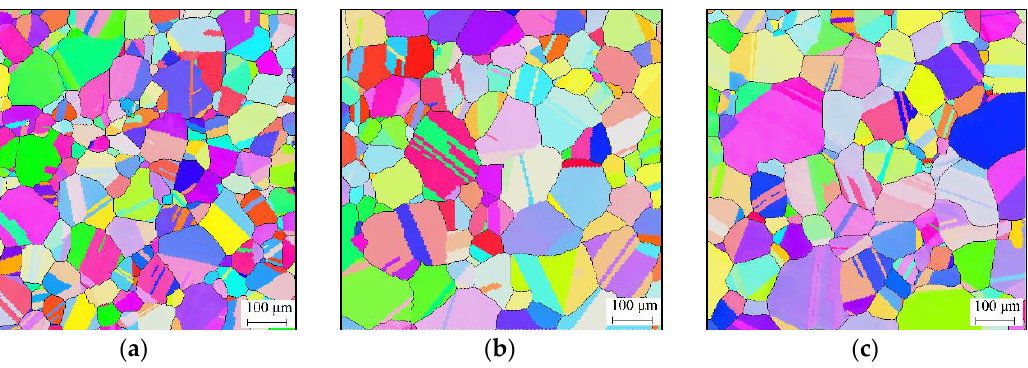
Figure 2. Grain structures under holding temperature of 1353 K and holding time of ( a ) 600 s, ( b ) 1500 s, and ( c ) 2400 s.